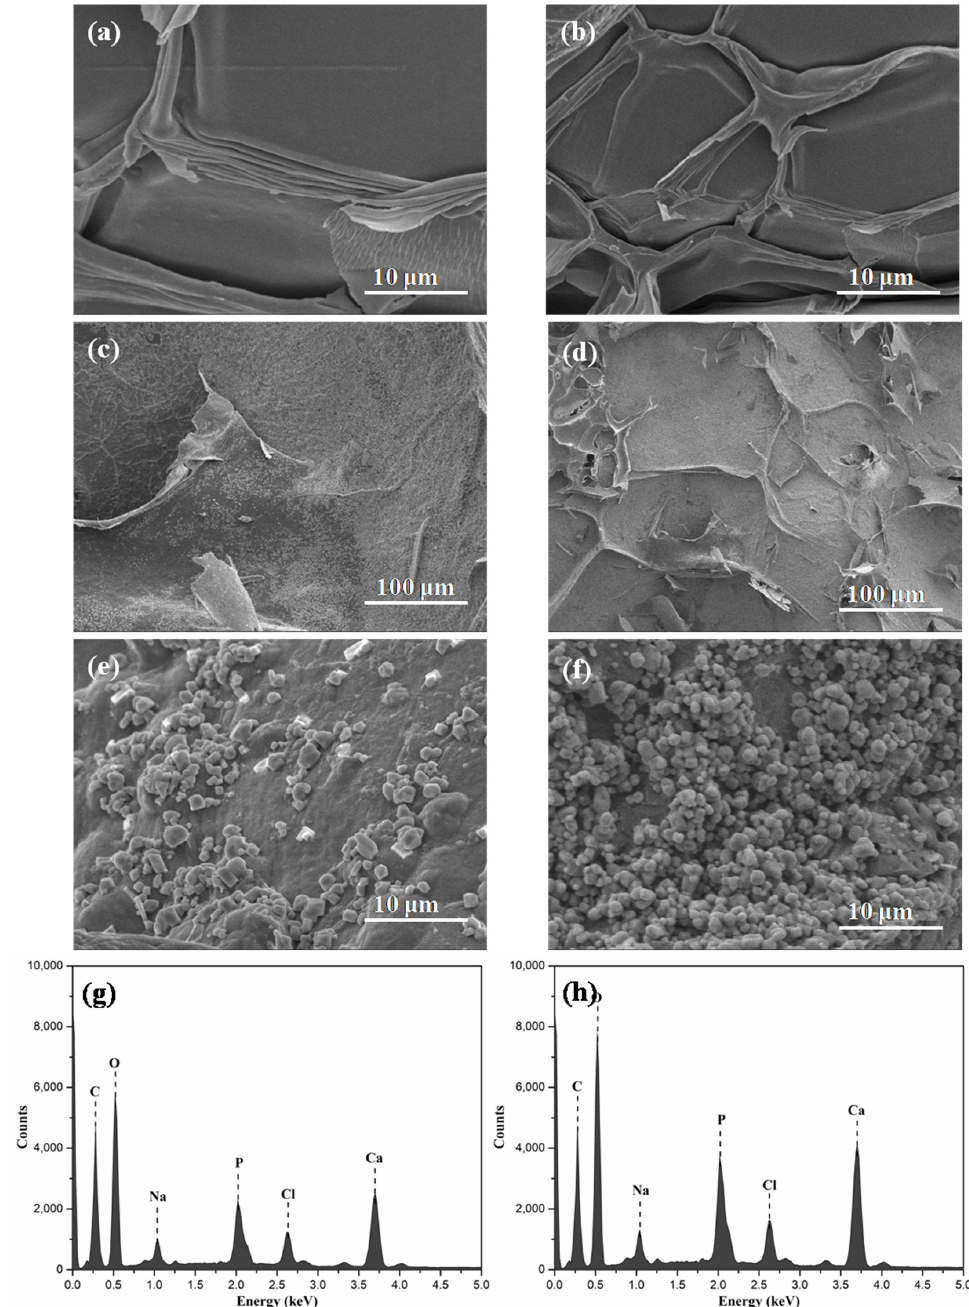
Figure 7. SEM images of untreated ( a ) Alg-CS-GT composite scaffolds and ( b ) Alg/0.3% BCNs-CS- GT composite scaffolds; SEM images of apatite formation on ( c , e ) Alg-CS-GT composite scaffolds and ( d , f ) Alg/0.3% BCNs-CS-GT composite scaffolds soaked in SBF for 14 days; EDX images of ( g ) Alg-CS-GT composite scaffolds and ( h ) Alg/0.3% BCNs-CS-GT composite scaffolds in SBF after 14 days.